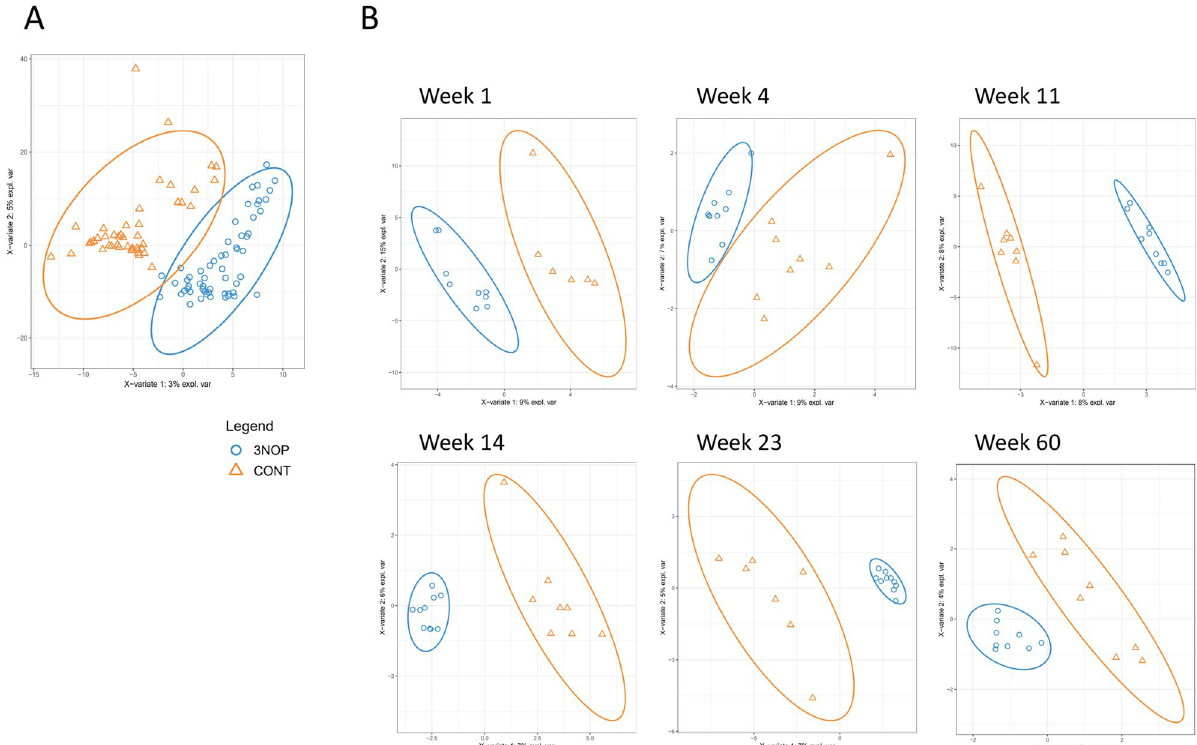
Figure 2. Supplementation of 3-NOP in dairy calves from birth to week 14 of life influences the rumen bacterial community profile. Sparse-PLS-DA loading weights plot of all weeks of ruminal bacteria across treatment groups (CONT, orange vs. 3-NOP, blue) ( A ). Sparse-PLS-DA revealed separation at all sampling weeks between treatment groups (CONT = orange and 3-NOP calves = blue) ( B